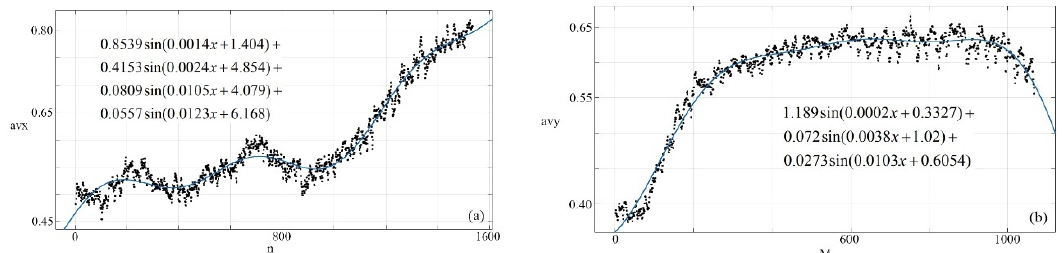
Figure 8. The model of brightness characteristic. ( a ) The model of row direction. ( b ) The model of column direction. The model is established by Equation (7).